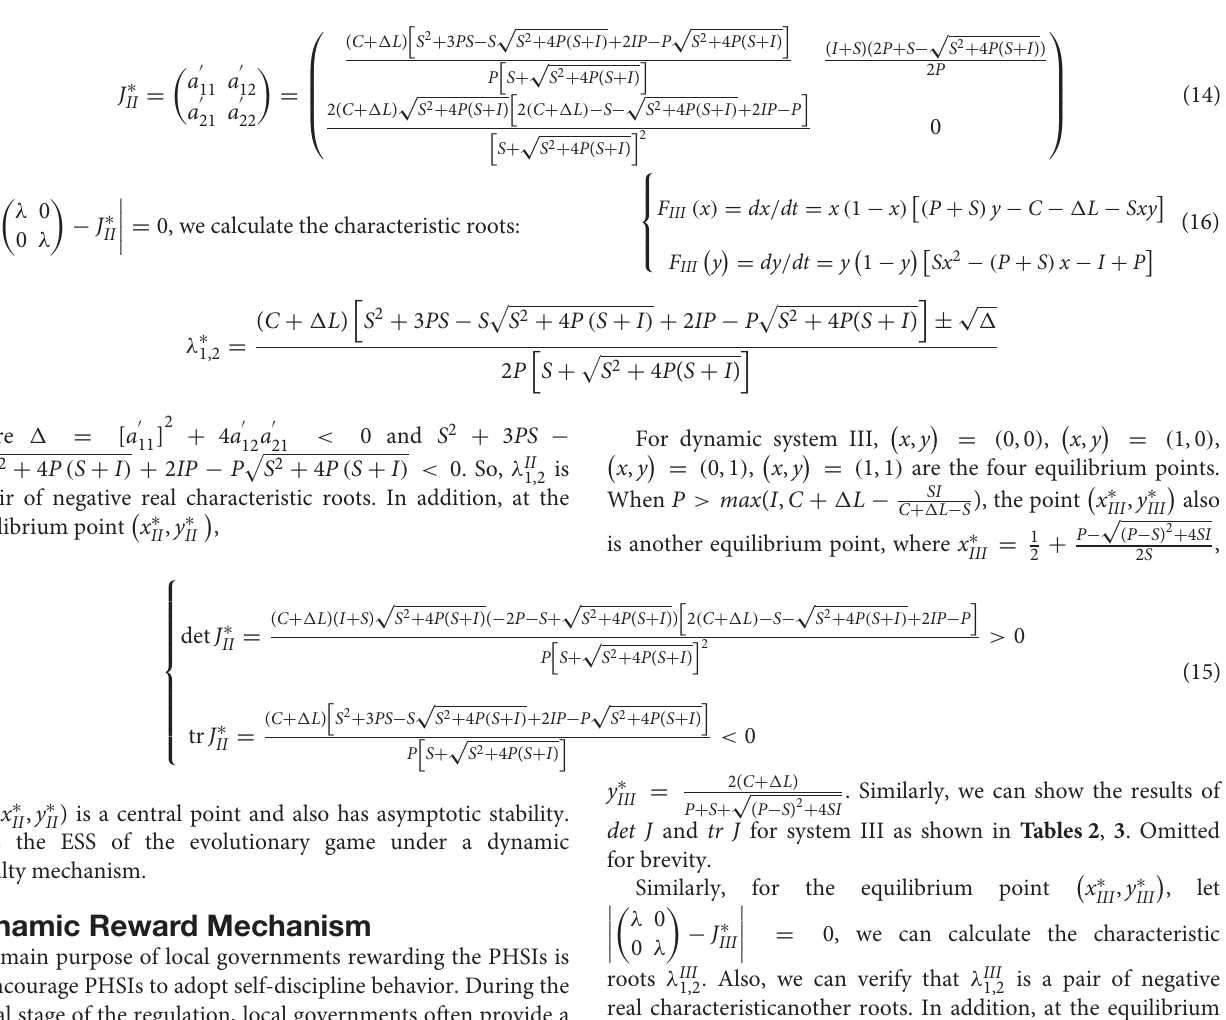
behavior, local governments will gradually reduce the reward level, hence it is the dynamic reward. In other words, the reward of local governments is related to the PHSIs’ choice of strategies. Specifically, the higher proportion of fraud behavior of PHSIs is associated with higher rewards to the PHSIs with self-discipline behavior. So, under a dynamic reward mechanism, the reward to PHSIs changes from the fixed value S to S ( x ) (1 x ) S . Then, = − substituting S ( x ) (1 x ) S for S in the payoff matrix of both = − players ( Table 1 ), the corresponding replicator dynamic